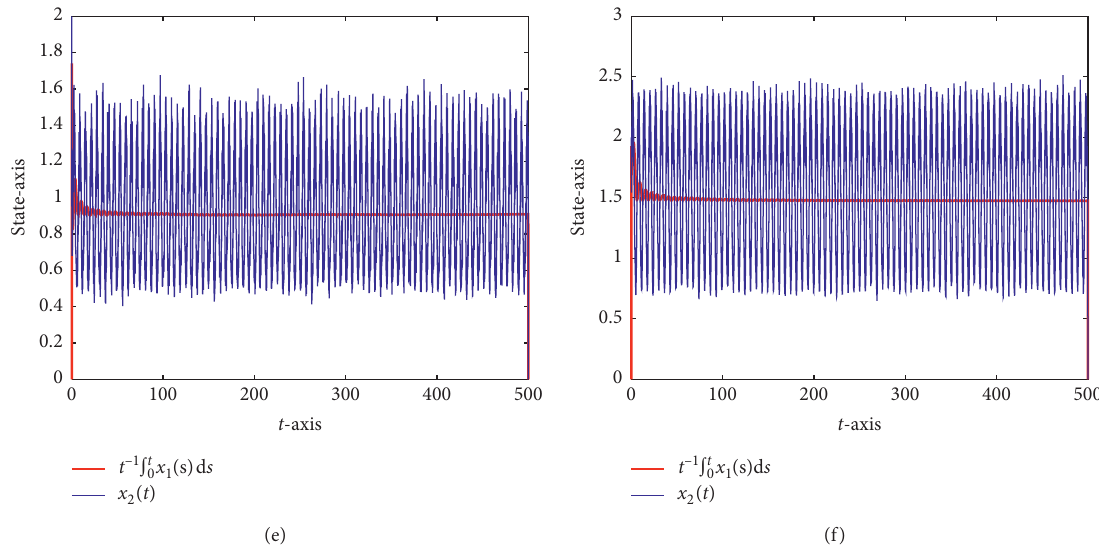
Figure 2: Extinction and permanence in the mean for system (2) with initial data x for (2) with only impulse effects ( σ i ( t ) � 0 ; λ ( t ) for (2) with only stochastic effects ( σ x 2 and permanence in mean of x ( t ) with σ x 2